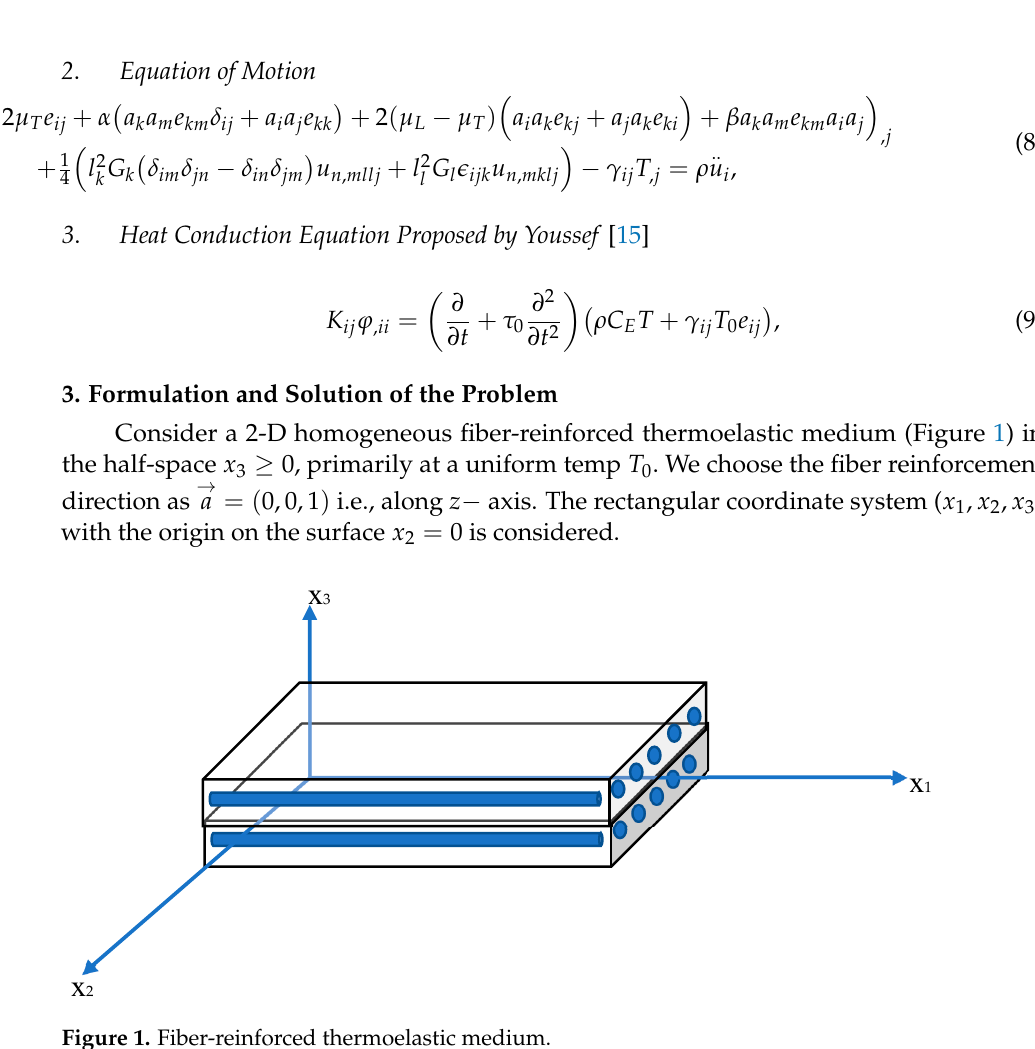
Figure 1. Fiber-reinforced thermoelastic medium.